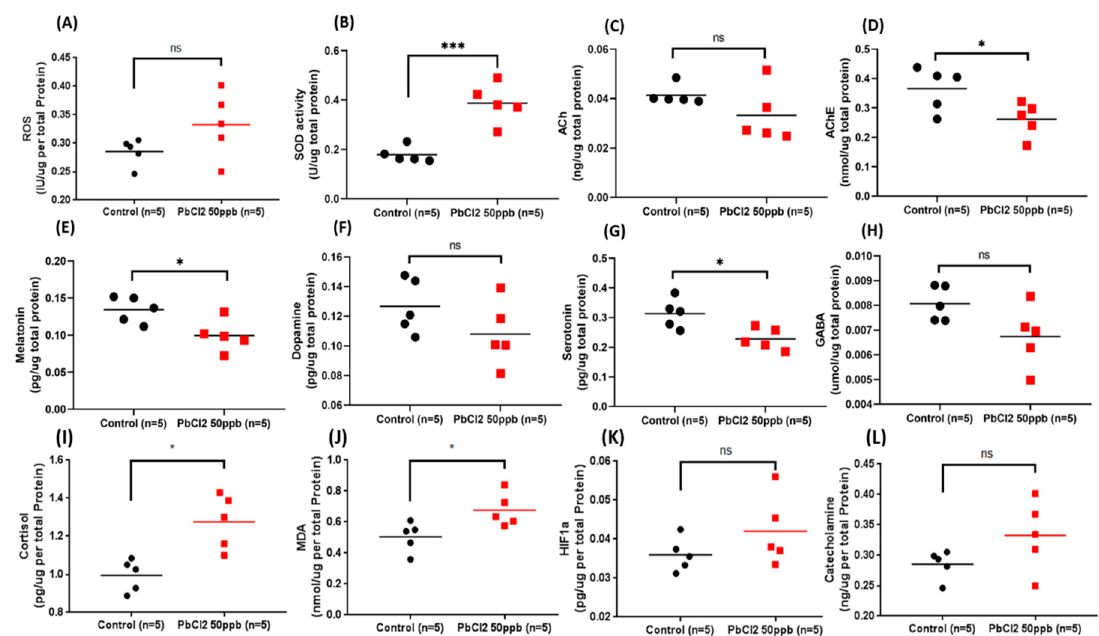
Figure 9. Biochemical parameters of the control and 50 ppb PbCl2-exposed fish. The levels of biomarkers, including ( A ) ROS (reactive oxygen species), ( B ) SOD (superoxide dismutase), ( C ) acetylcholine, ( D ) acetylcholine esterase, ( E ) melatonin, ( F ) dopamine, ( G ) serotonin, ( H ) GABA, ( I ) cortisol, ( J ) MDA (malondialdehyde), ( K ) HIF-1 α , and ( L ) catecholamine were measured. Data are expressed as mean values ( n = 5; * p ≤ 0.05, *** p ≤ 0.001 tested by t -test).